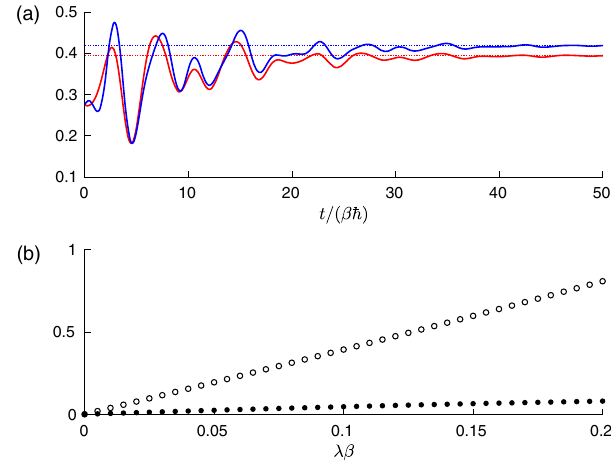
FIG. 16. Approximate fluctuation relation with error bound. (a) f ð t Þ is plotted as the red solid line, and r ð t Þ the blue solid line, for the interval t= ð β ℏ Þ ∈ ½ 0 ; 50 (cid:2) . In the ideal case, f and r would be identical. In the interval, the maximal error is f ð t Þ − r ð t Þj ≈ 0 . 0795 . This should be compared max t= ð β ℏ Þ ∈ ½ 0 ; 50 (cid:2) j with the upper bound in Proposition 12, which is approximately f ð t Þ and 0.806. The dotted lines correspond to the limits lim t → þ ∞ r ð t Þ , where the system approaches the fixpoint of the lim t → þ ∞ master equation. (b) For otherwise fixed settings, the maximum f ð t Þ − r ð t Þj is plotted (filled circles) against error max t= ð β ℏ Þ ∈ ½ 0 ; 50 (cid:2) j the value of λβ . The empty circles correspond to the error bound in Proposition